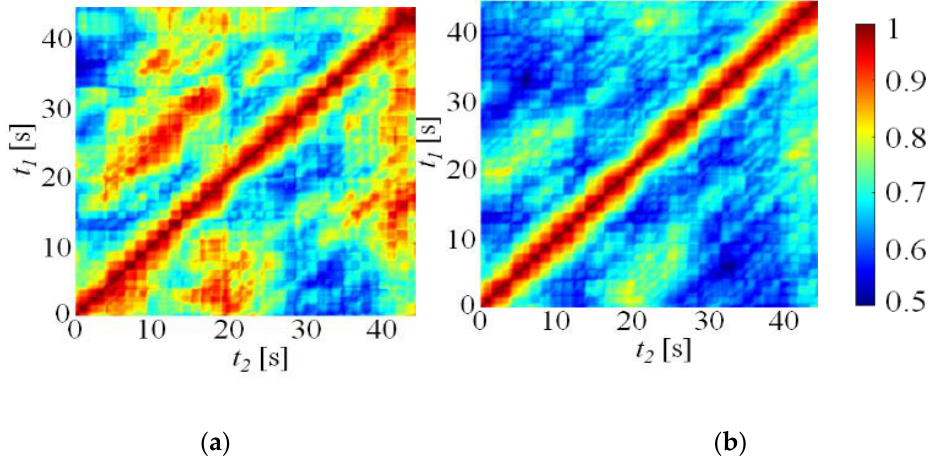
Figure 6. Cross-correlations of heat fluxes at two positions of Ch7 at Q ele = 2 W, ( a ) 7a and 7d, ( b ) 7c and 7d.